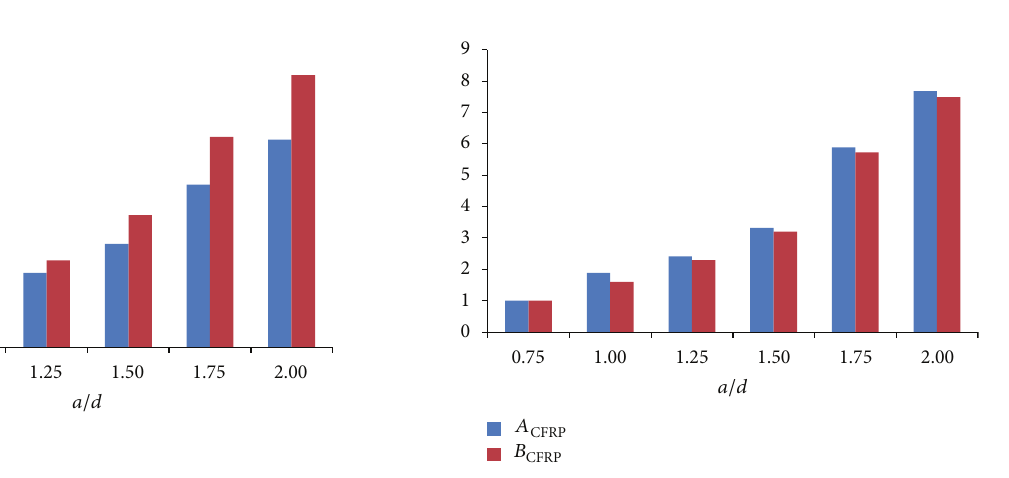
Figure 7: Comparison of average transverse strains of CFRP- strengthened RC struts for different applied load